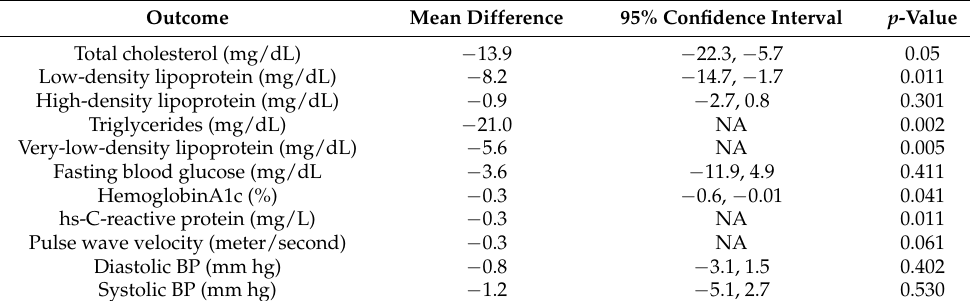
Table 6. Difference between almond-supplemented (estimated 60 g/day) and almond-free healthy diabetes diets on cardiovascular and glycemic risk biomarkers over 24 weeks [56]. Outcome Mean